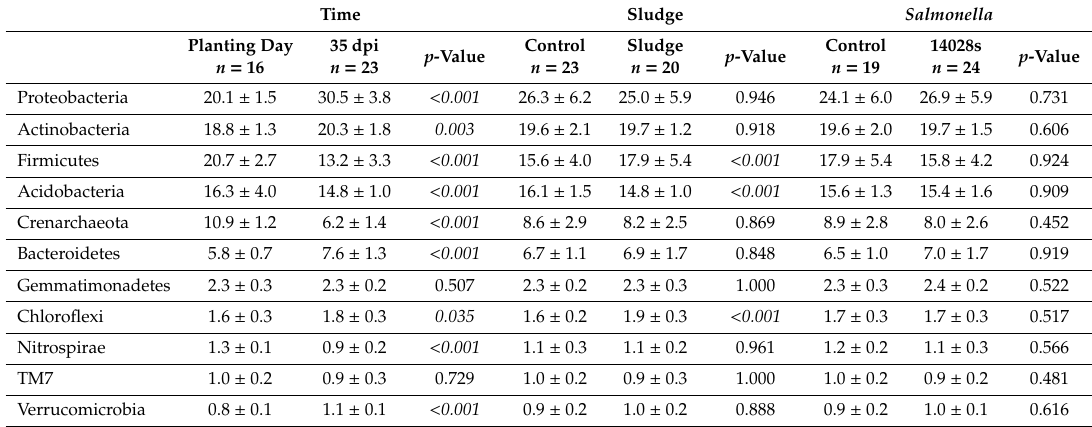
Table 1. The soil microbial community on phylum level is influenced by time and addition of sludge compost. However, it is not influenced by the presence of Salmonella. Relative abundance of phyla is expressed as a percentage of the total bacterial population. Results were evaluated using Student’s t -test with Benjamini–Hochberg adjusted p values, with p ≤ 0.05 considered significant (bold). The results are expressed as mean ± SD from four biological replicates ( n =